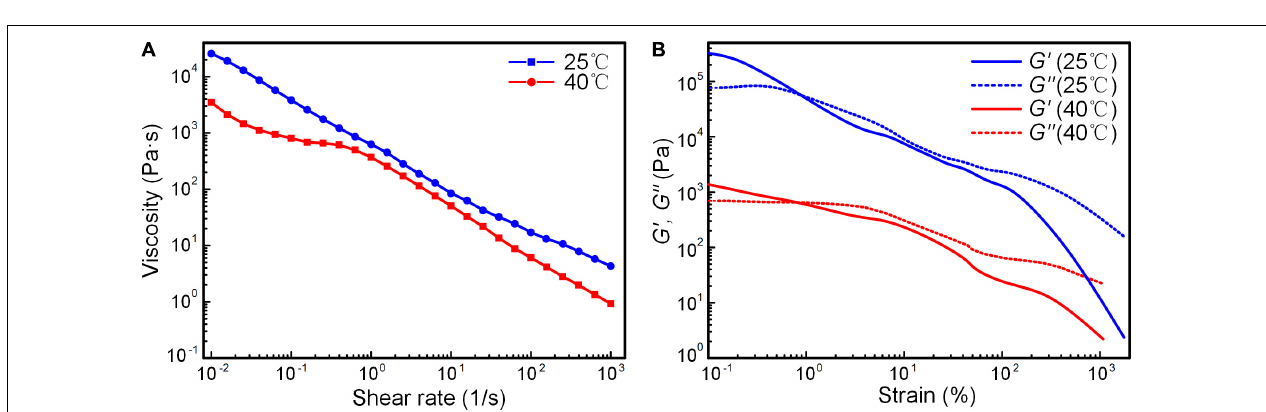
FIGURE 1 | Schematic diagram of manufacturing and shape-shifting under different stimuli of 4D printed PU-SMPVC bilayer structures.